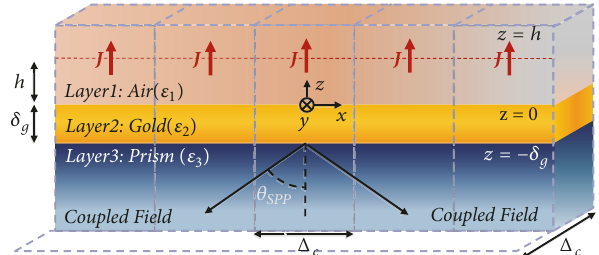
Figure 8: Particularization of the equivalent electromagneticmodel for the SPCE